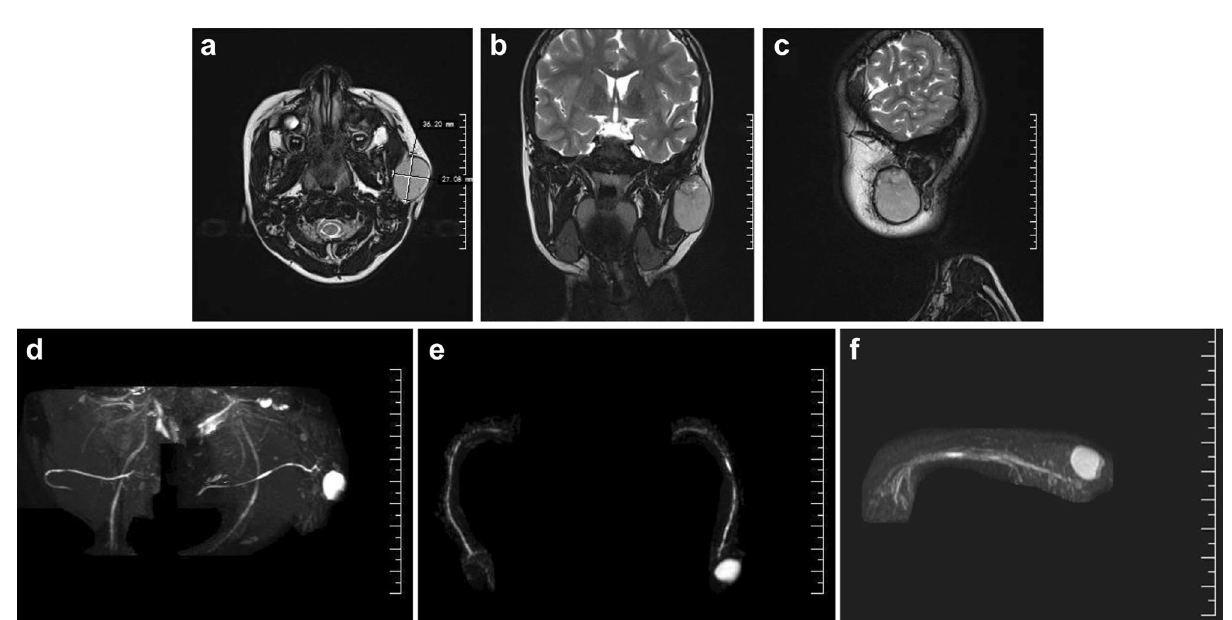
Figure 3. Magnetic resonance imaging (MRI) imaging findings of typical SCSG. On MRI, tumors tend to be roundish in shape, with clear boundaries. T2 images showed long signals or mixed long and short signals; ( a ) horizontal plane; ( b ) coronal plane ( c ) sagittal plane. MRH detected lesions located in the posterior lower pole of the parotid gland; ( d ) coronal plane ( e ) horizontal plane ( f ) sagittal